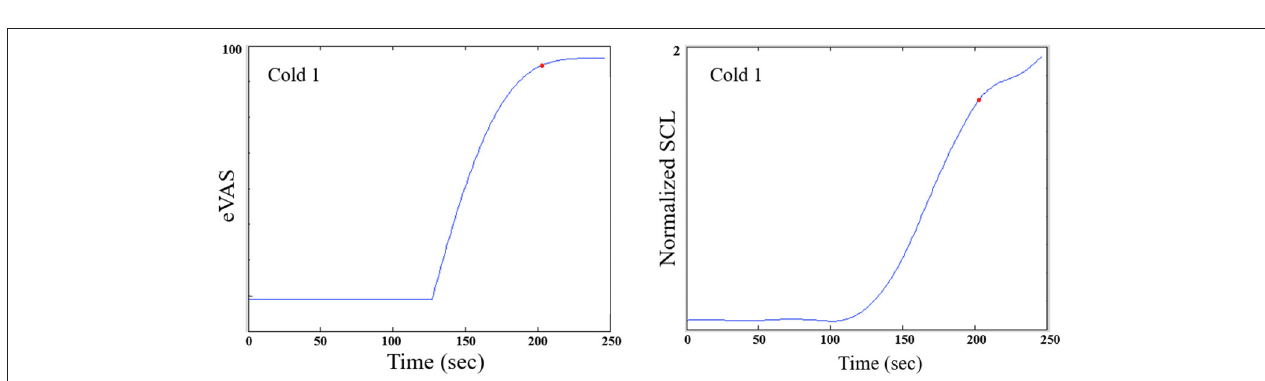
FIGURE 3 | For the cold pressor, the eVAS tends to grow monotonically throughout the task. Thus, a region defining Region III strictly as following the “peak" could be of zero duration. We thus define a function of the peak as the point at which the eVAS does not change > 0.005. The red dot shown above marks the onset of Region III for this participant. Typically, the SCL does not drop during Region III of the Cold pressor test; thus, we measure Region III over a fixed 2-min